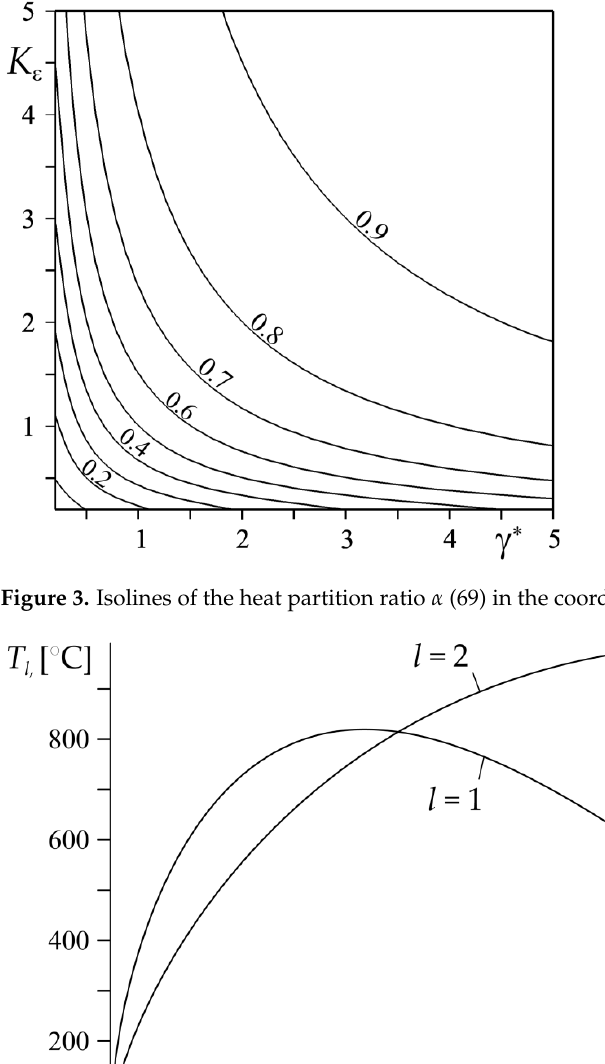
T , 2,1 = l (55) and (56) on the heated surfaces 0 = z of the Figure 4. Evolutions of temperature Figure 4. Evolutions of temperature T l , l = 1,2 (55) and (56) on the heated surfaces z = 0 of the l considered semi-spaces made of FGMs. considered semi-spaces made of